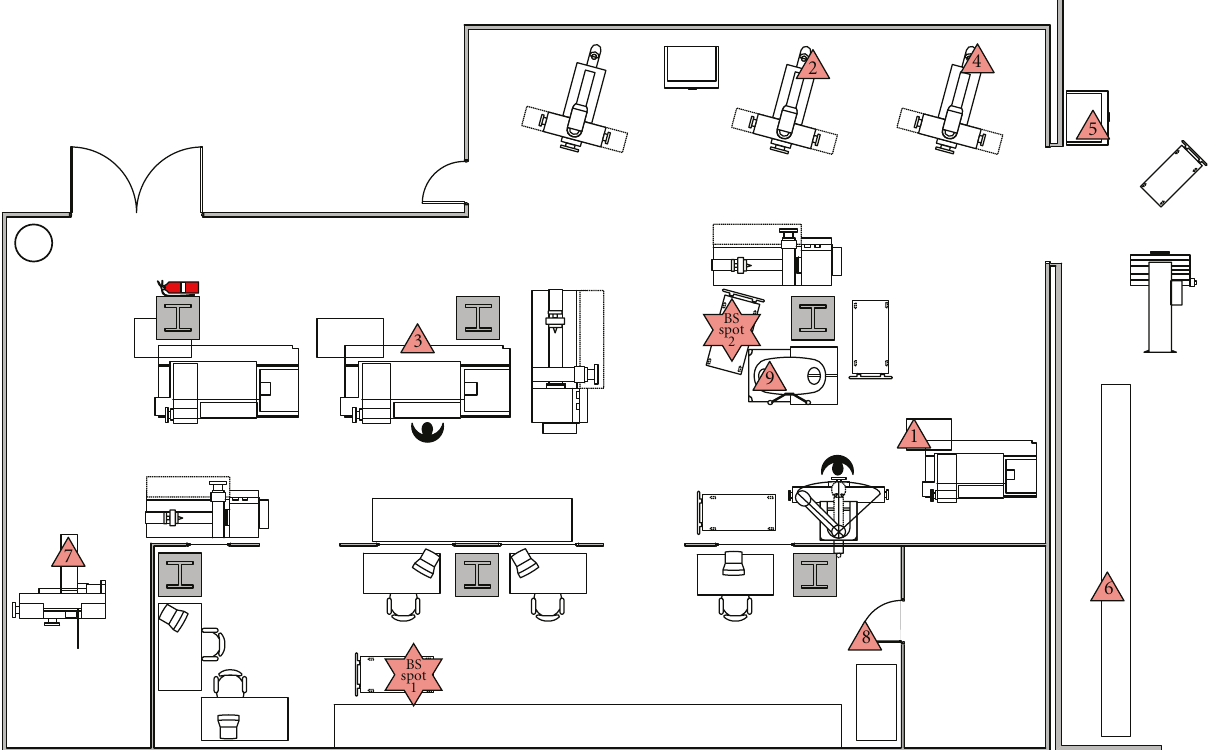
Figure 6: Machine shop